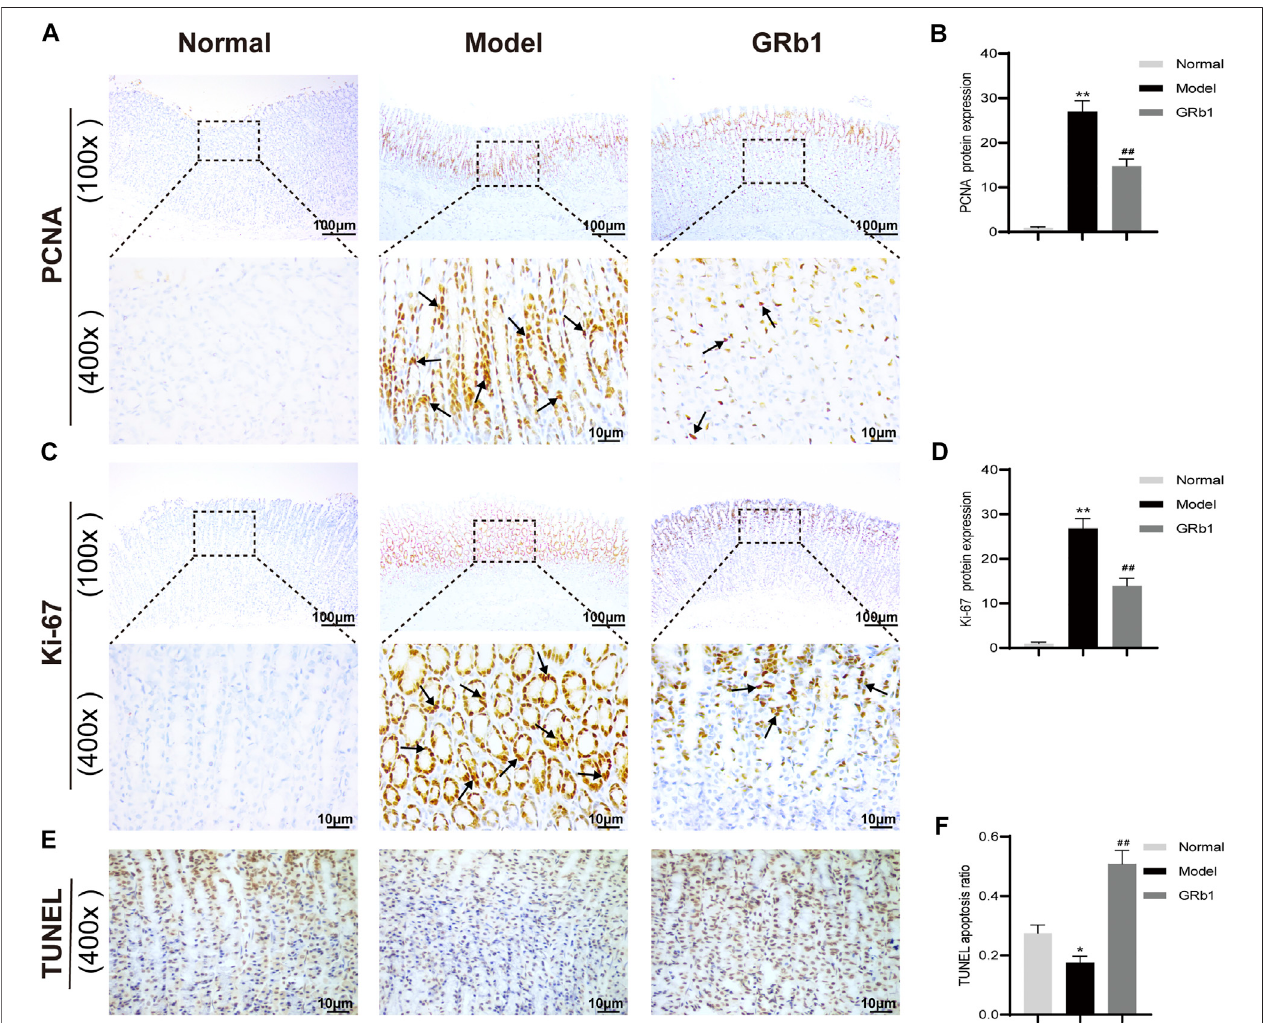
FIGURE6| GRb1inhibitshyper-proliferationofepithelialcellsandacceleratesapoptosisinGPLmodelrats.Representative imagesshowing (A) PCNAexpression and (C) Ki-67expressionaswellas (E) TUNELapoptoticcellsingastrictissuesectionsfromeachgroup(magni fi cation × 100and × 400).Semi-quantitativeanalysisof (B) PCNA protein expression levels and (D) Ki-67 protein expression levels as well as (F) TUNEL apoptosis ratio in each group ( n (cid:1) 10). * p < 0.05 and ** p < 0.01 vs. Normal group. # p < 0.05 and ## p < 0.01 vs. Model group. Data are presented as mean ± SEM. Abbreviations: GRb1, ginsenoside Rb1; GPL, gastric precancerous lesions; PCNA, proliferating cell nuclear antigen; TUNEL, TdT-mediated dUTP nick-end labeling; SEM, standard error of mean.